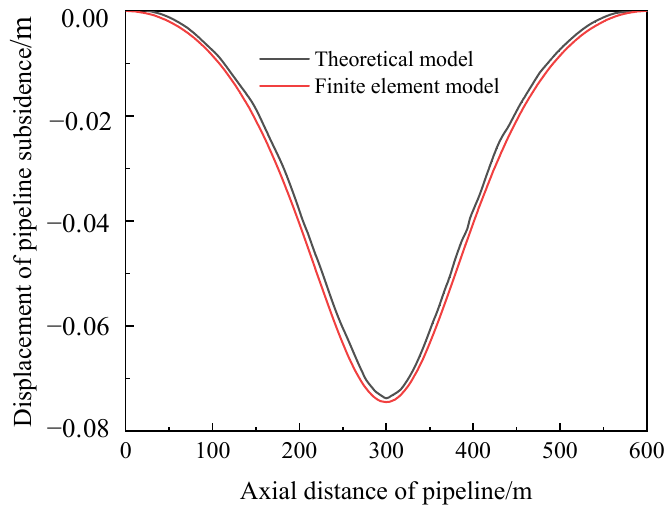
Figure 4. Comparison for model validation.